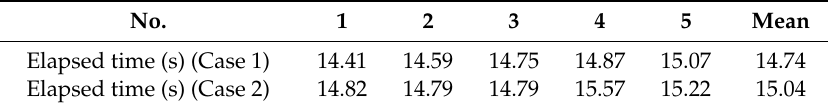
Table 3. Elapsed time for simulating the